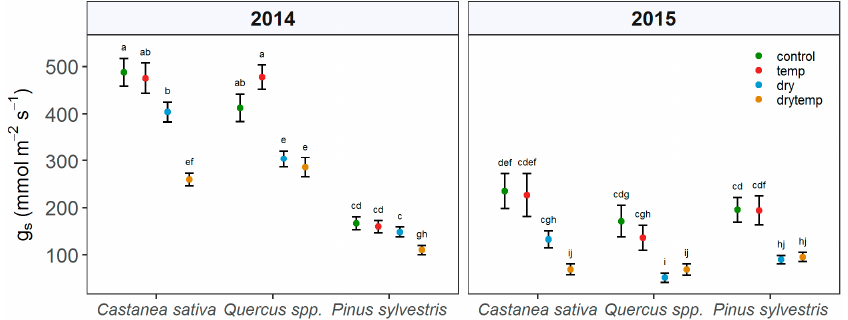
Figure 3. Variation of mean estimated stem water potential ( Ψ STEM ) and their standard errors induced by ( a ) species and treatment; ( b ) species and year, as well as ( c ) treatment and year. Estimates within each panel that do not share the same letter are significantly different at p < 0.05.